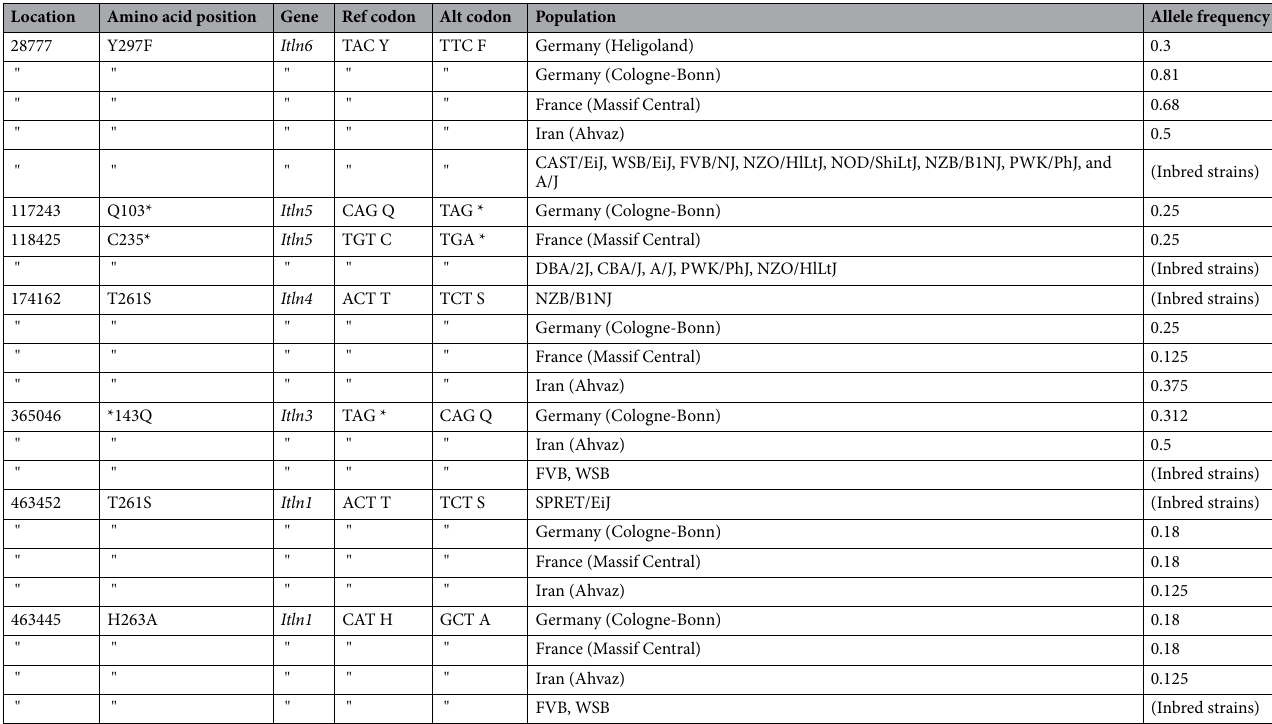
Table 1. Putative functional amino acid variants identified in intelectin genes (all lab mice strains shown were homozygous for the alternative